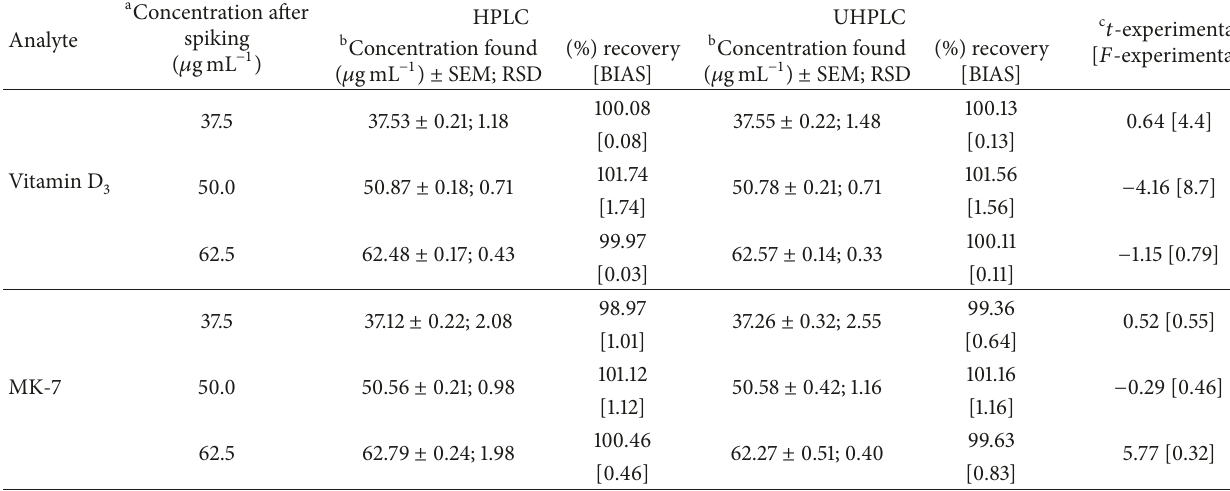
Table 4: Accuracy studies of vitamin D 3 and MK-7 by HPLC and UHPLC.